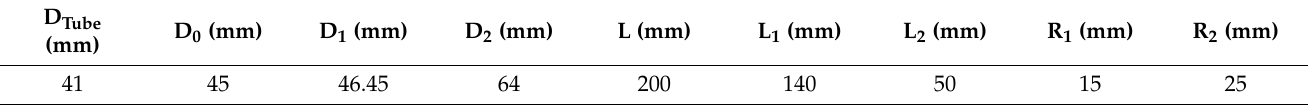
Figure 3. Shape and dimensions of the objective part. Table 2. The dimensions of the objective part.